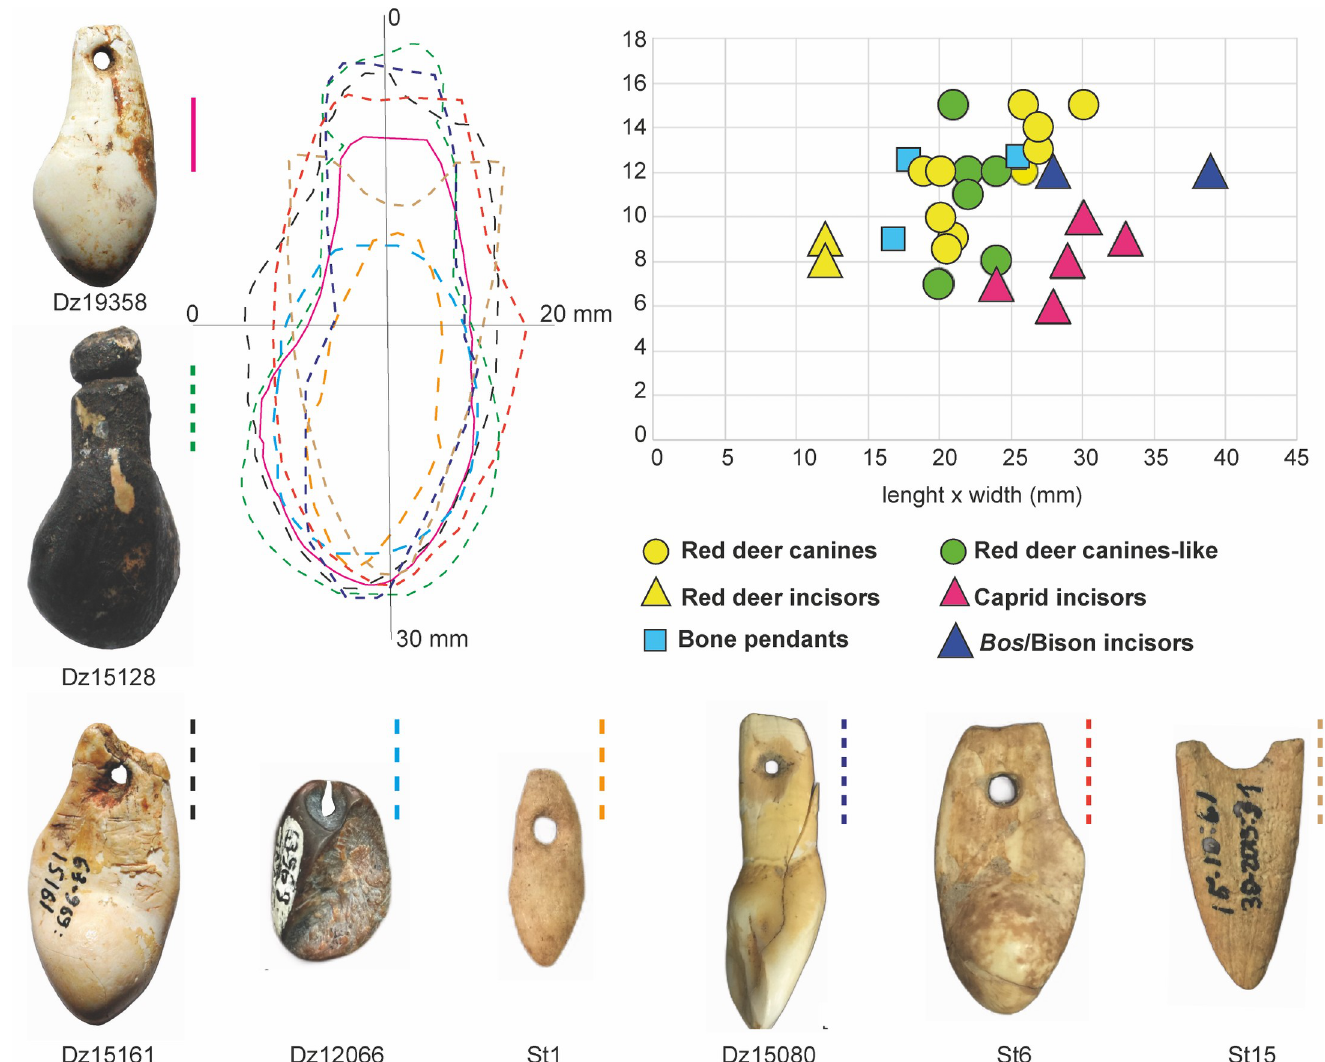
Fig 7. Morphometric comparison of pendants. Morphometrics of the pendants show the choice of a regular size and similar shape of both teeth and bone pendants.